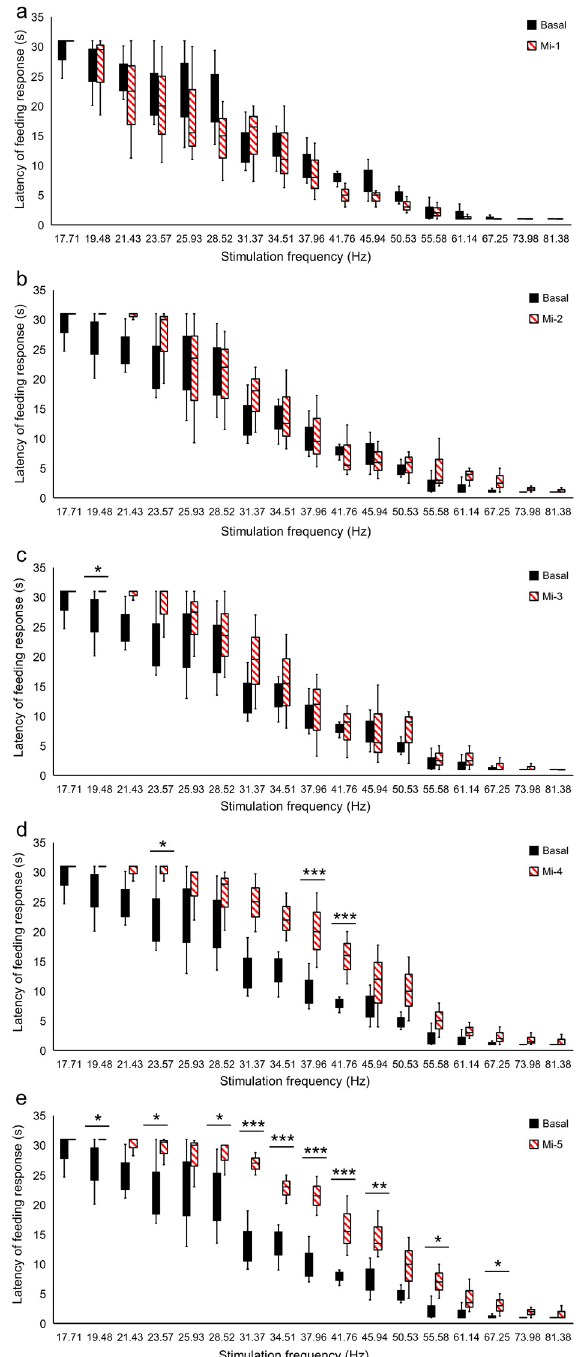
Figure 3. Destabilization of the VTA electrical stimulation (Es ‐ VTA) ‐ induced feeding response (FR) directly after morphine injection at different doses [0.25 μ g/0.5 μ L (Mi ‐ 1 group) ( a ) 0.5 μ g/0.5 μ L (Mi ‐ 2 group) ( b ), 1.0 μ g/0.5 μ L (Mi ‐ 3 group) ( c ), 1.25 μ g/0.5 μ L (Mi ‐ 4 group) ( d ), and 1.5 μ g/0.5 μ L (Mi ‐ 5 group) ( e )] injected into the PPN in the ipsilateral hemisphere (red ‐ hatched bars) (n = 5 for each dose) compared to artificial cerebrospinal fluid injection (ACSF; 0.5 μ L) into the PPN as basal groups (black ‐ filled bars) ( a – e ). * p < 0.05, ** p < 0.01, and *** p < 0.001 (Tukey’s post hoc test) indicate significant differences in the FR latency at different frequencies of Es ‐ VTA in the Mi ‐ 1, Mi ‐ 2, Mi ‐ 3, Mi ‐ 4, and Mi ‐ 5 experimental groups compared to the basal group.